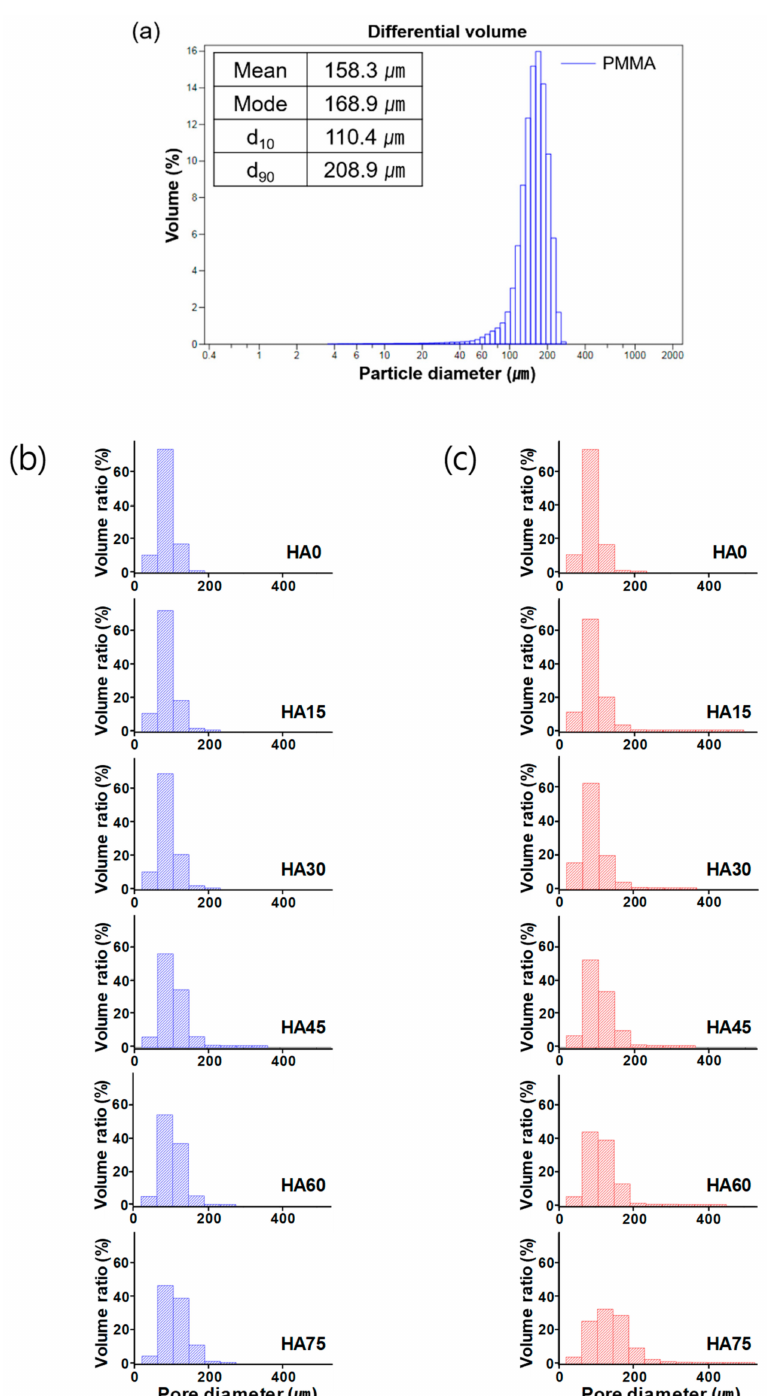
Figure 6. ( a ) Particle size distribution of PMMA powder; pore size distribution of HA sca ff olds with respect to the PMMA addition amount, ( b ) before sintering and ( c ) after